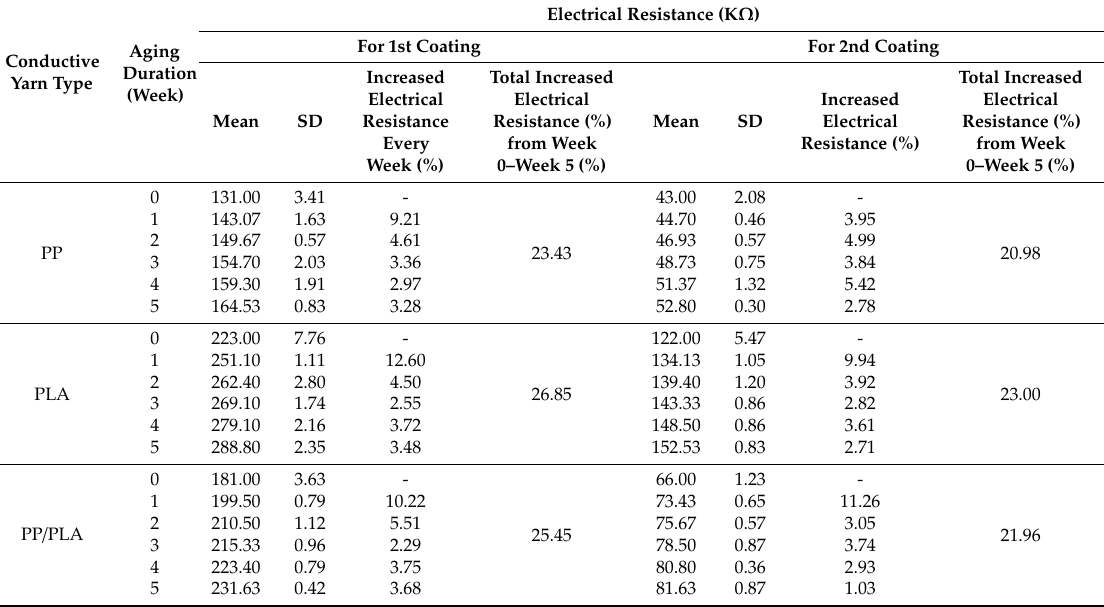
Table 6. Aging e ff ect of PEDOT:PSS coated conductive